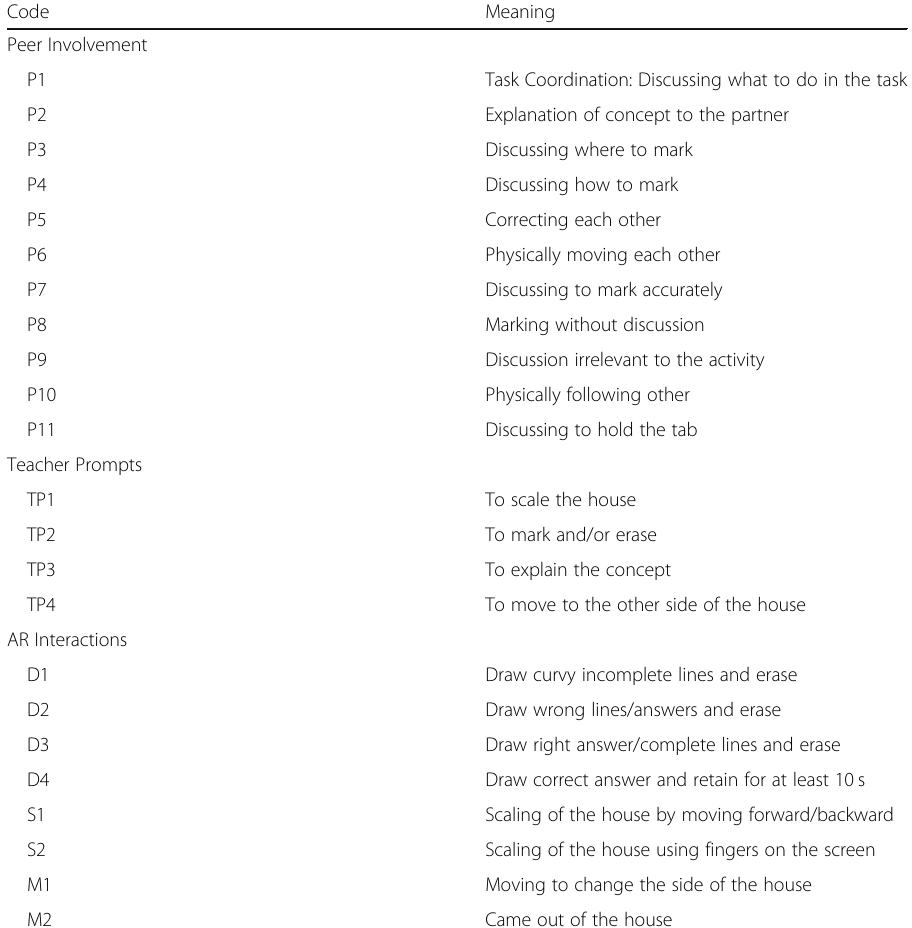
Table 1 Coding scheme of collaborative learning behavior while performing the AR learning